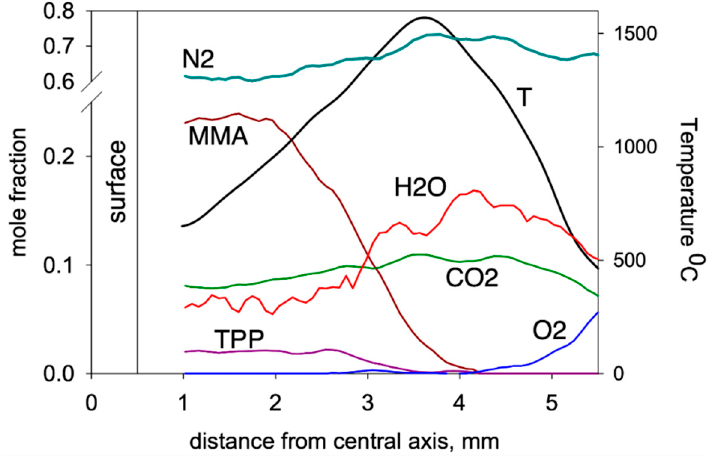
Figure 15. Species concentration and temperature profiles in the flame of a downward 90% PMMA + 10% TPP slab (4.6 mm thick) at a height of 3 mm from the flame front.